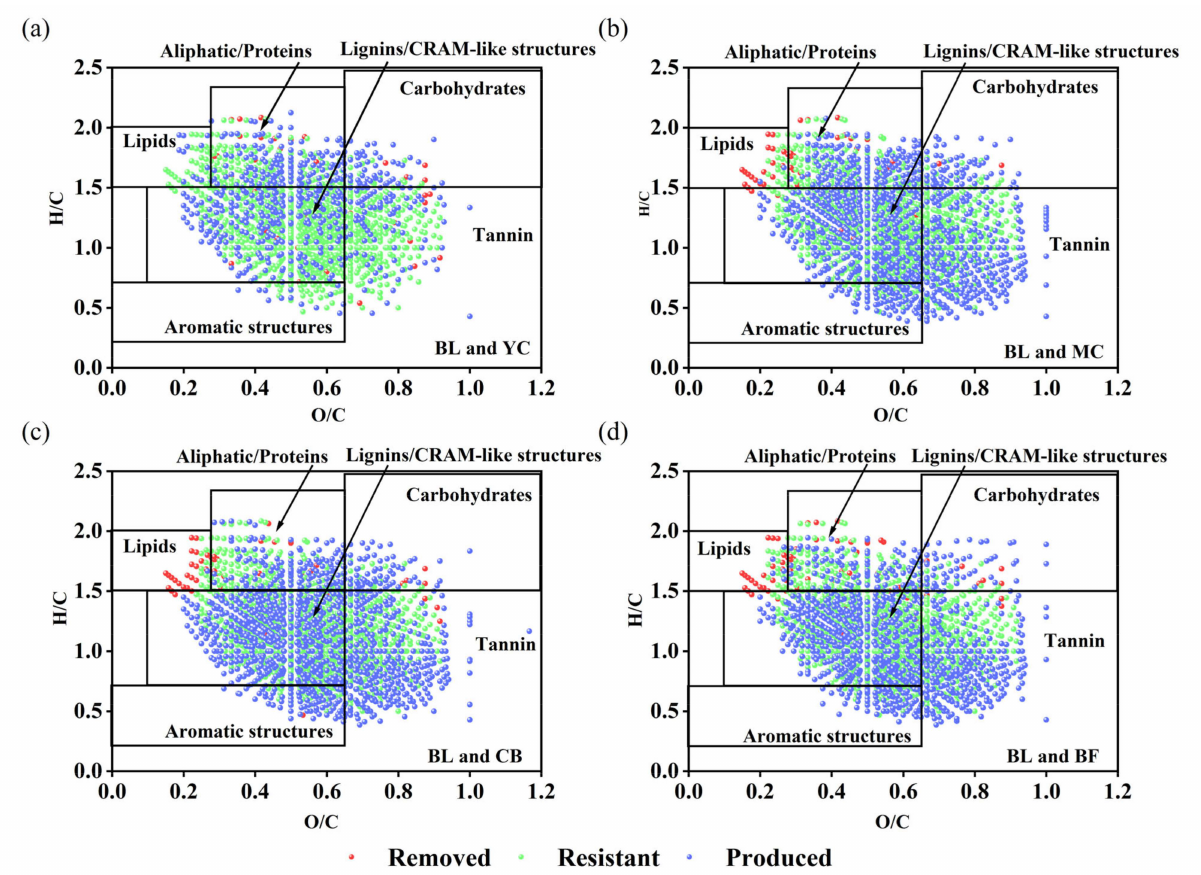
Figure 2. Van Krevelen diagrams of soil dissolved organic matter (DOM) comparisons between the BL (as control) and YC ( a ), MC ( b ), CB ( c ), and BF ( d ). Points in red represent DOM molecules that disappeared after vegetation restoration (removed), points in green represent DOM molecules that were unchanged (resistant), and points in blue denote new molecules that appeared during vegetation restoration (produced). BL: bare land; YC: newly restored young coniferous forest; MC: slightly more mature coniferous forest; CB: mixed coniferous and broadleaf forest; BF: broad-leaved